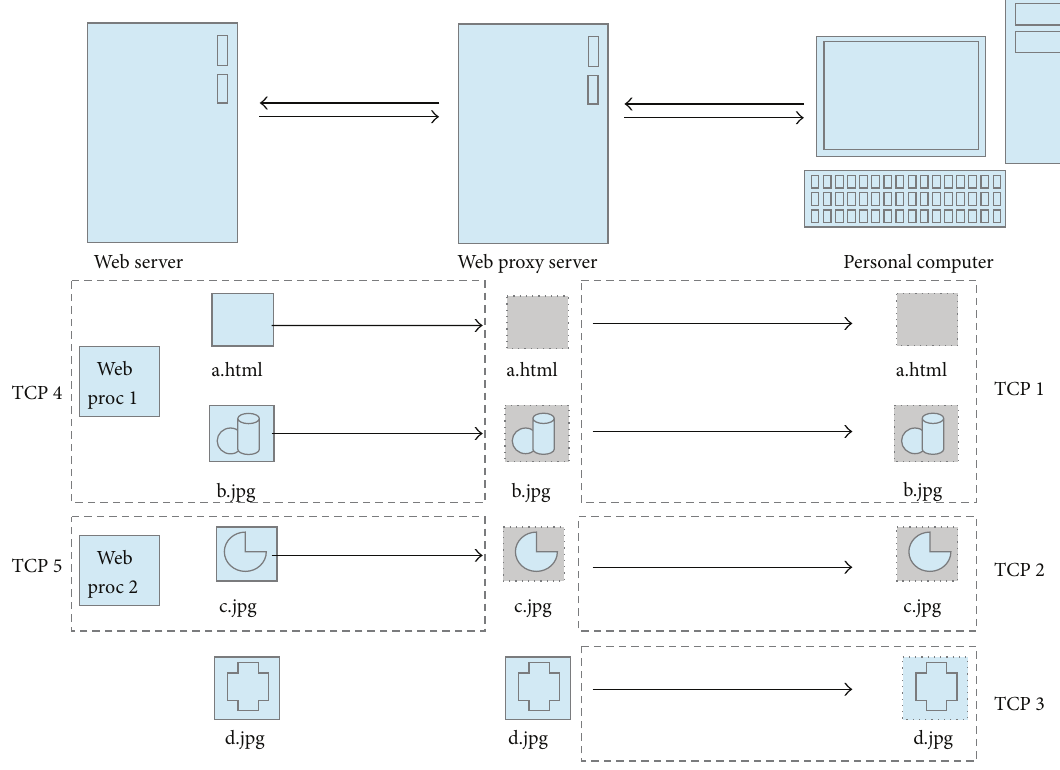
Figure 1: Retrieval of web